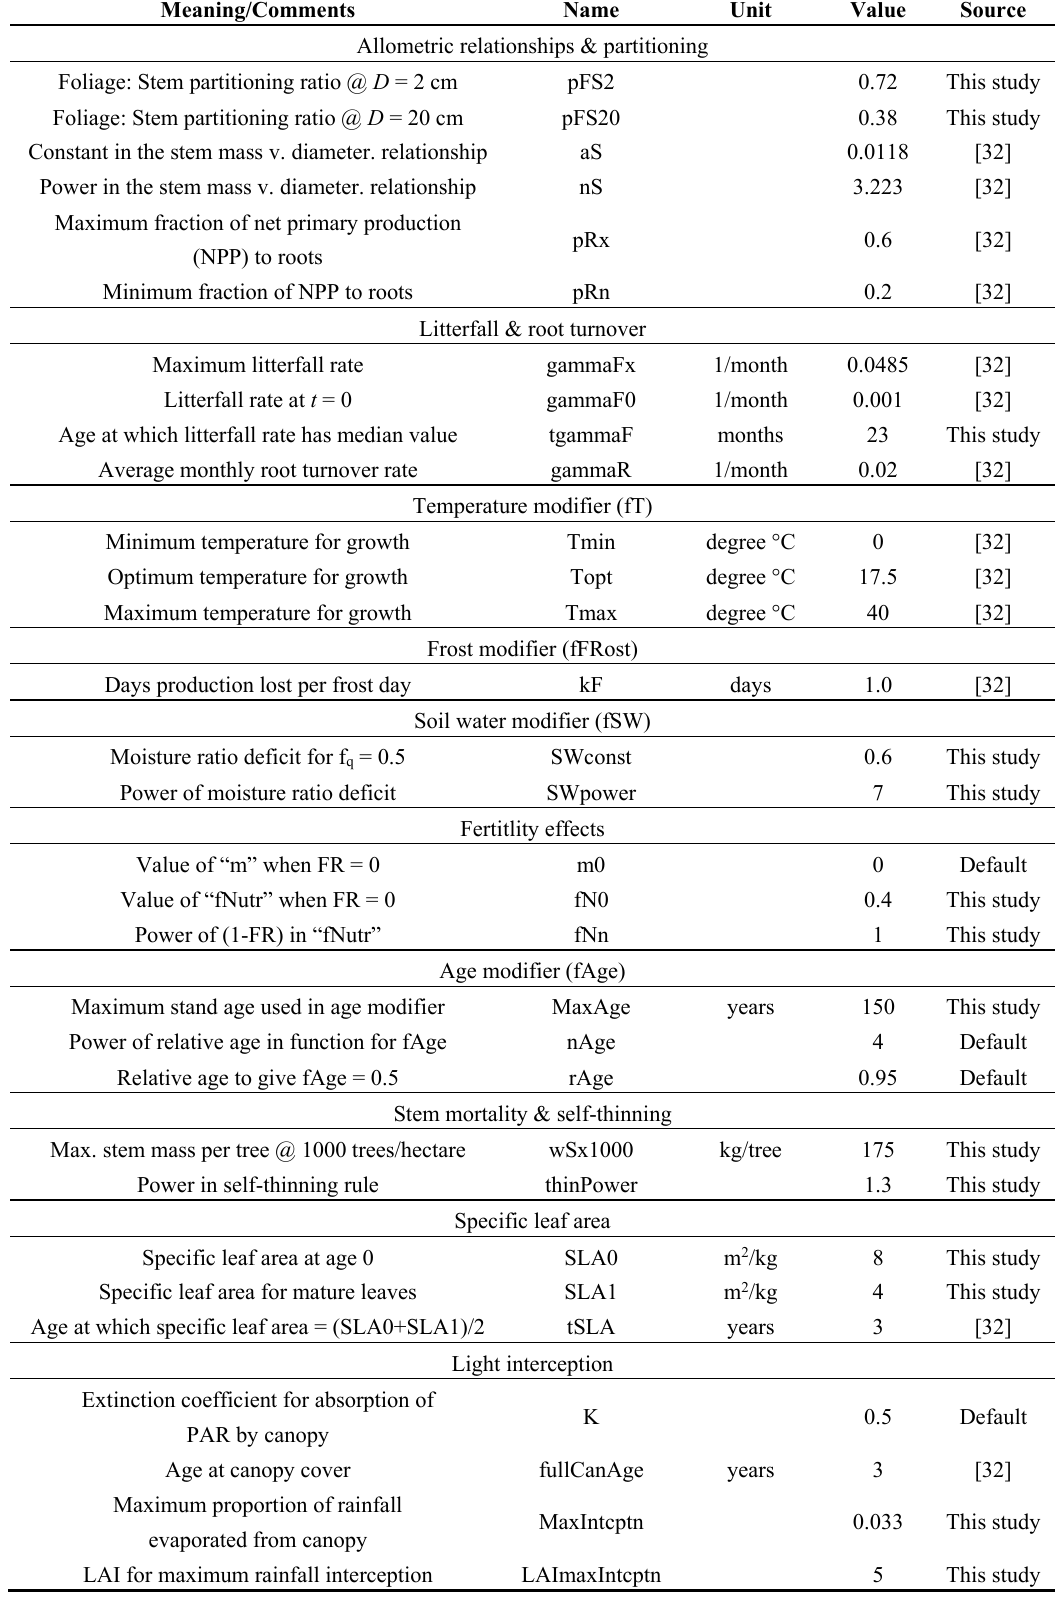
Table 1. Physiological Principles in Predicting Growth (3-PG) Parameters of Chinese fir.